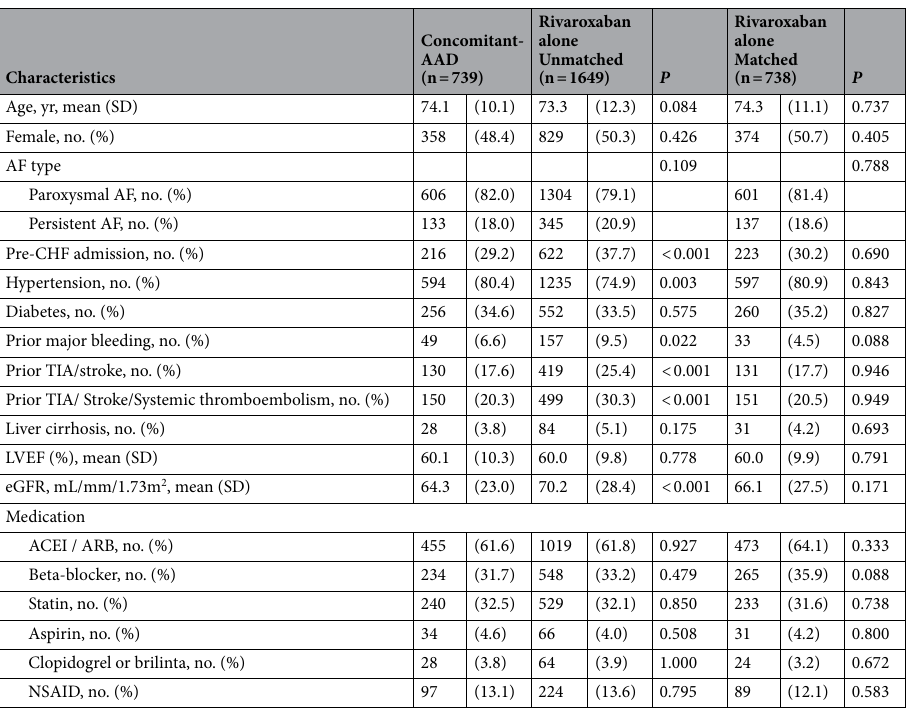
Table 1. Baseline characteristics of atrial fibrillation patients receiving rivaroxaban with and without anti- arrhythmic drugs before and after propensity score